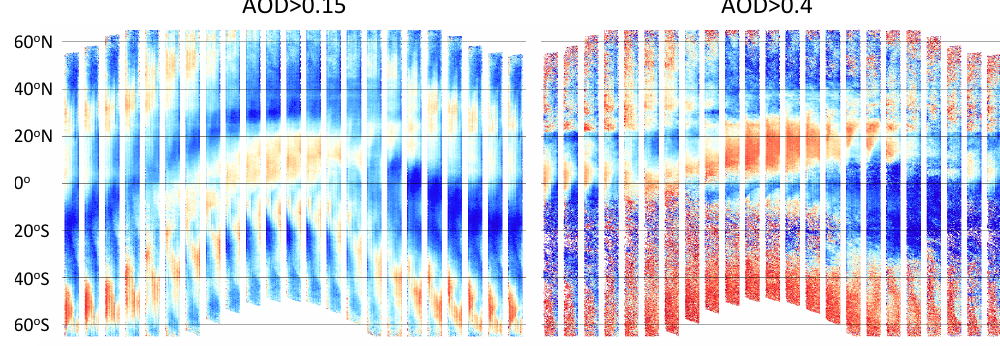
Fig. 9. Same as Fig. 8 but for different ranges of AOD: (a) AOD > 0.15 and (b) AOD > 0.4.